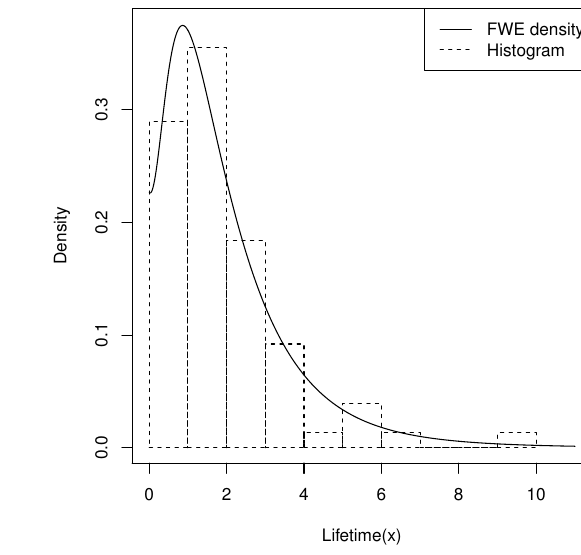
Figure 4. Fitted density plot of the FWE distribution for failure times data.